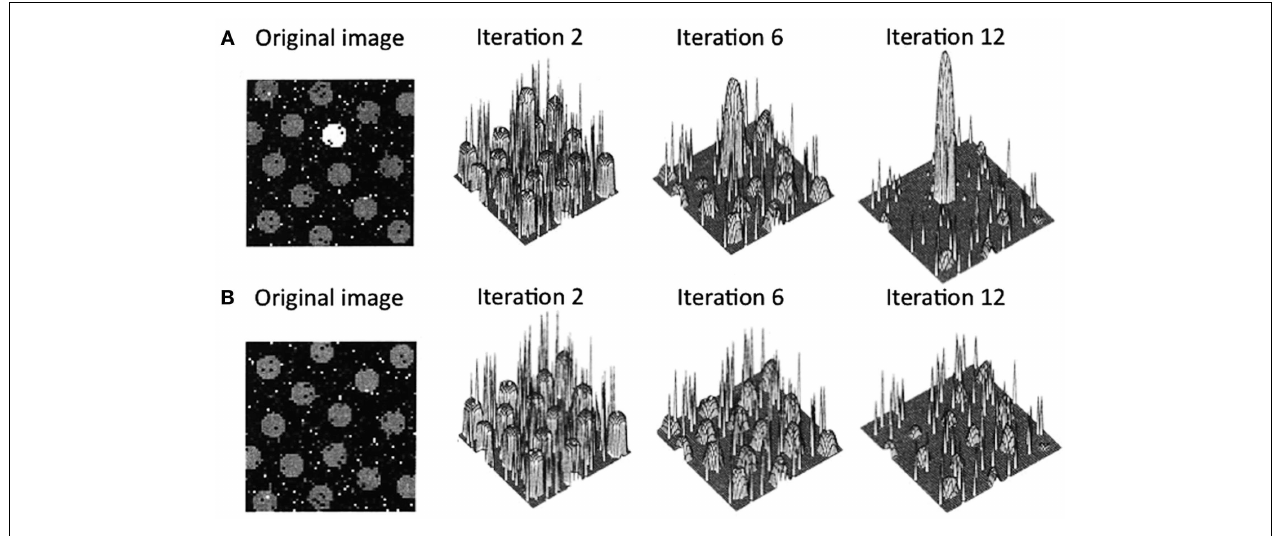
gains strength while suppressing the weaker activation locations. In case (B) , the original image has multiple locations that initially have similar activation levels. Here, all the peaks mutually suppress each other, leading to overall suppression of activation in the saliency map. Figure adapted from Itti and Koch